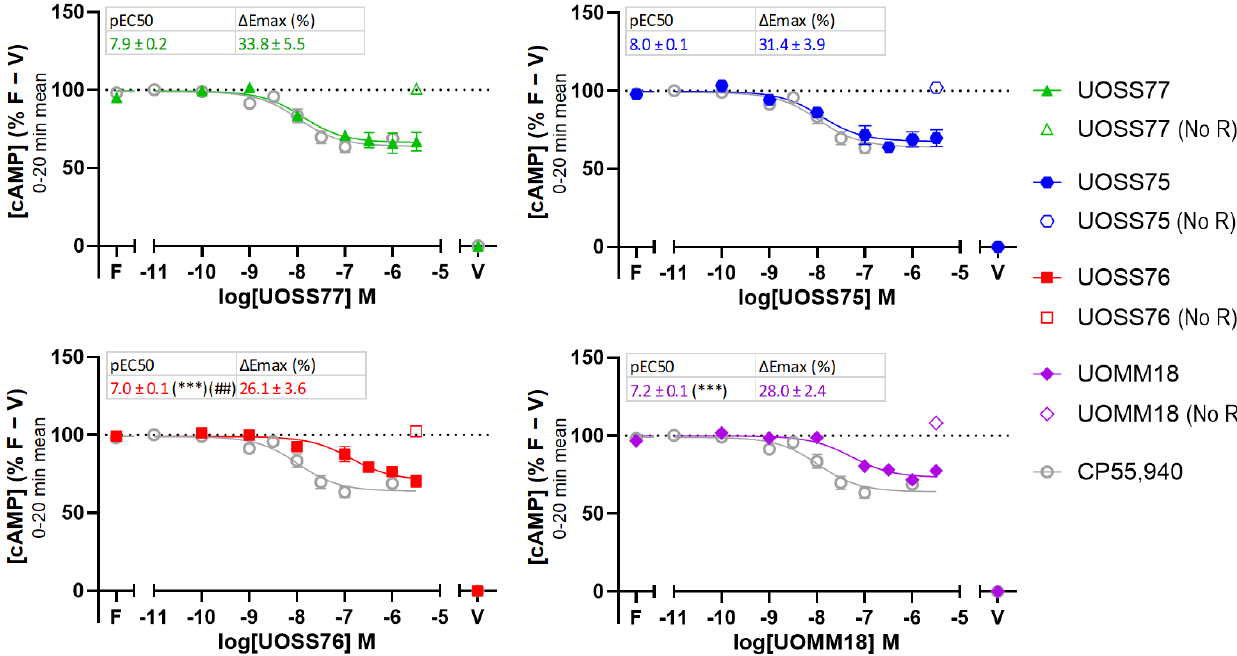
Figure 2. cAMP levels in response to varying concentrations of compounds of interest co-stimulated with 5 µ M forskolin in cells transfected with human CB2 or control plasmid (“No R”). Biosensor measurements over a 20 min drug treatment were averaged, then normalised to vehicle-treated without forskolin (V; 0%) and vehicle-treated with forskolin (F; 100%) conditions. pEC 50 and E max are displayed in boxes for test compounds. E max is expressed as absolute magnitude percentage decrease from 100% ( ∆ E max ), such that larger ∆ E max represents greater efficacy. CP55,940 has pEC 50 8.0 ± 0.1 and ∆ E max 35.1% ± 3.5%. Plotted and parameter data are mean ± SEM from three to four independent experiments. Asterisks and hashes represent a significant difference from the parameters for CP55,940 and UOSS77, respectively. ## and *** represent p < 0.01 and < 0.001, respectively. An advantage of utilising real-time signalling biosensors is that these enable anal-